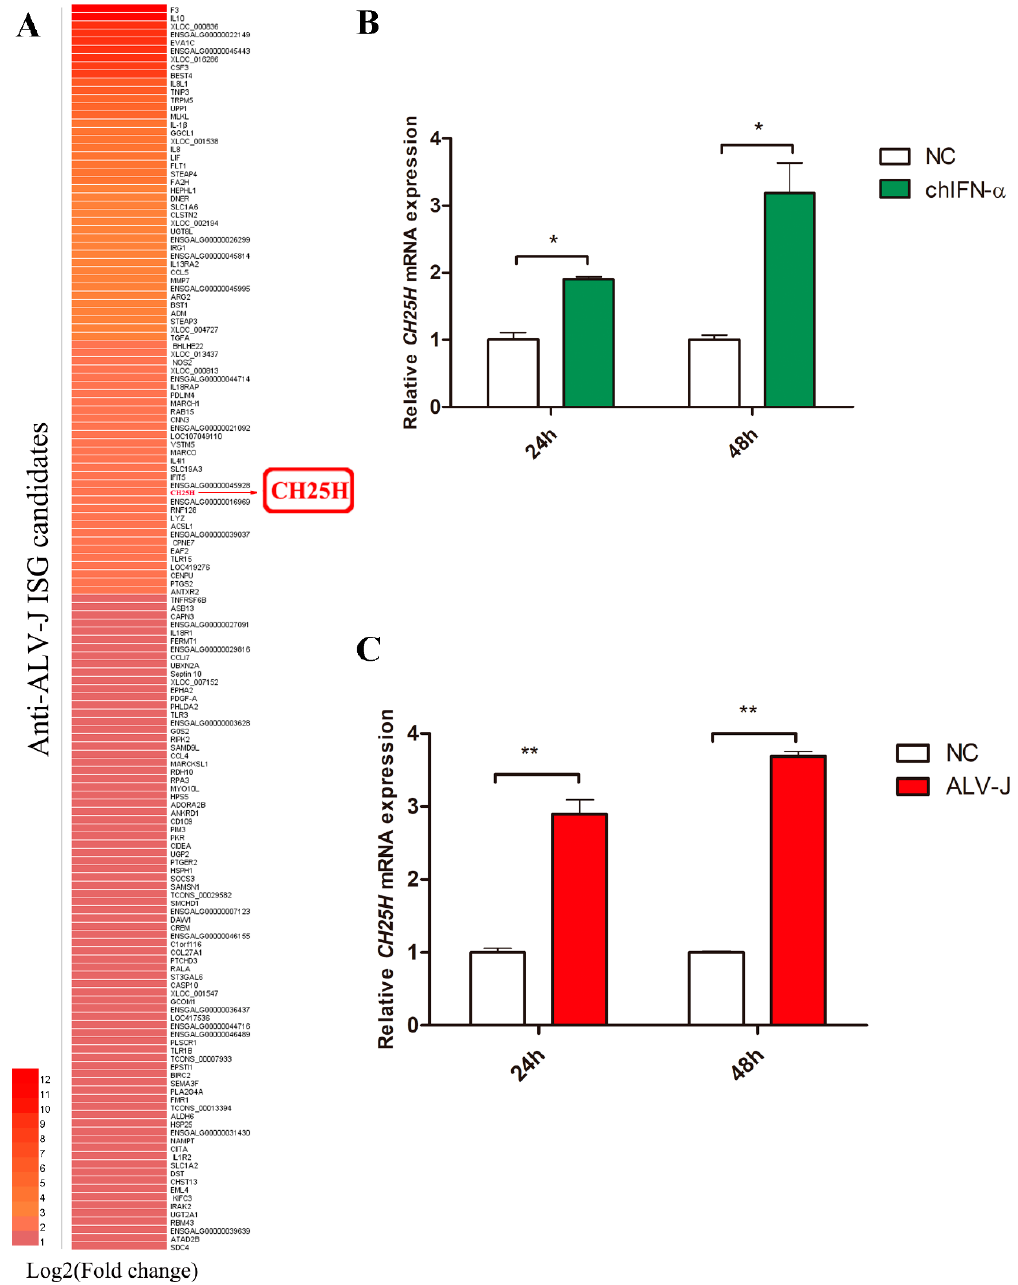
Figure 2. The expression of chCH25H is upregulated by ALV-J infection and IFN- α treatment in DF1 cells. ( A ) Heatmap of 152 chicken anti-ALV-J ISG candidates. ( B ) The expression of chCH25H was significantly increased in DF1 cells after treatment with 1000 U/mL IFN- α 24 h and 48 h. ( C ) DF1 cells were infected with ALV-J strain SCAU-HN06. chCH25H expression was significantly increased at 24 and 48 hpi. * p < 0.05; ** p < 0.01.